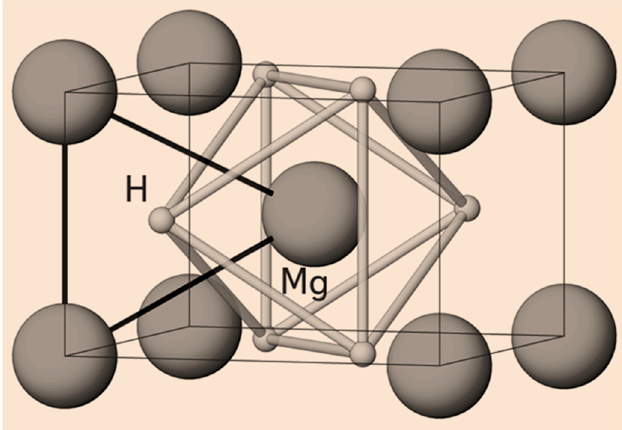
Figure 2. Tetragonal crystalline lattice of the rutile-type α -MgH 2